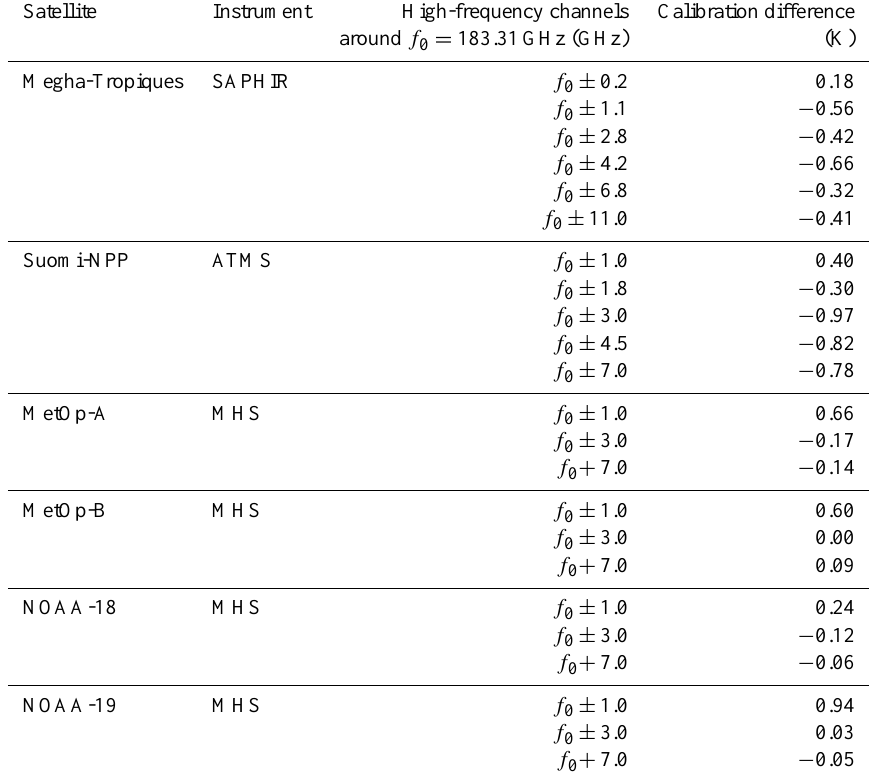
Table 2. Mean calibration differences versus the GPM GMI radiometer for the cross-track sounders listed in Table 1 (GMI – sounder) for channels near the f 0 = 183.31GHz absorption line, computed by the GPM XCAL intercalibration team.